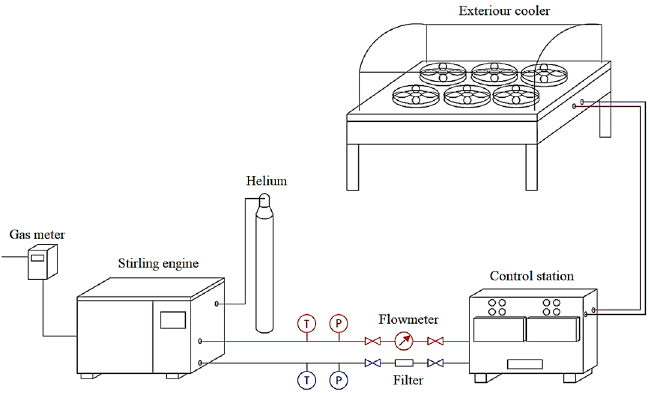
Figure 7. The experimental setup.